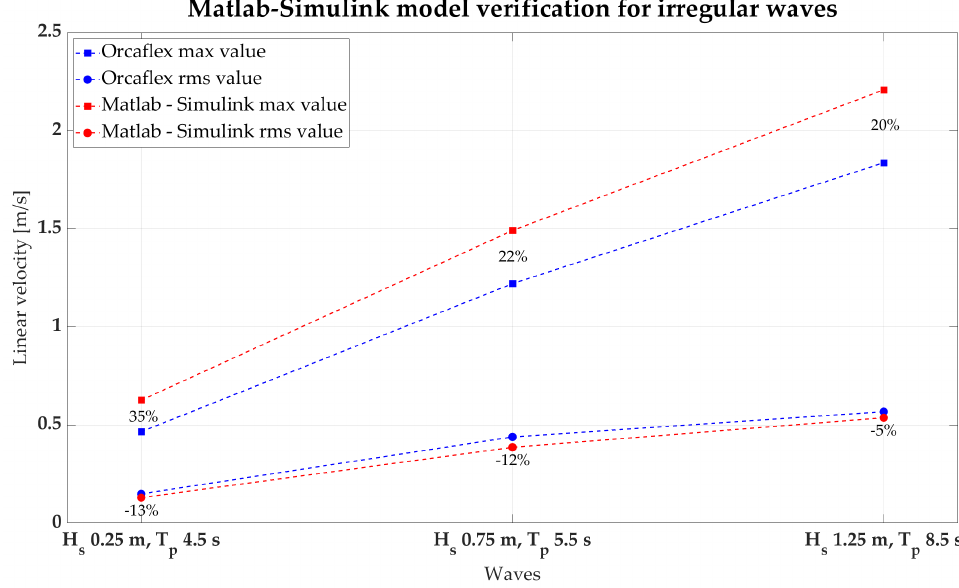
Figure 6. Irregular wave comparison between Orcaflex and the Matlab-Simulink